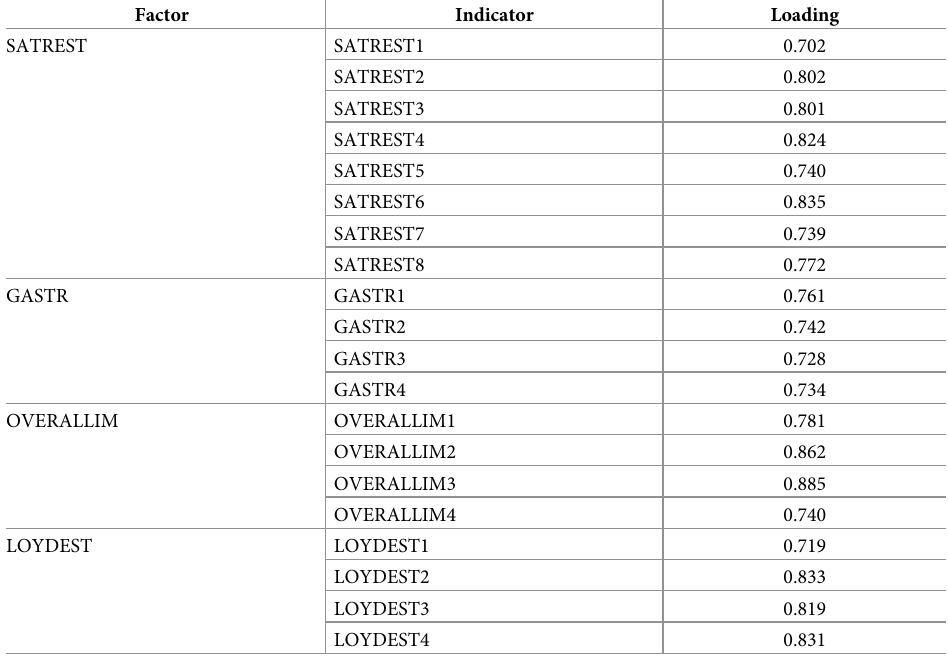
Table 2. Individual item reliability